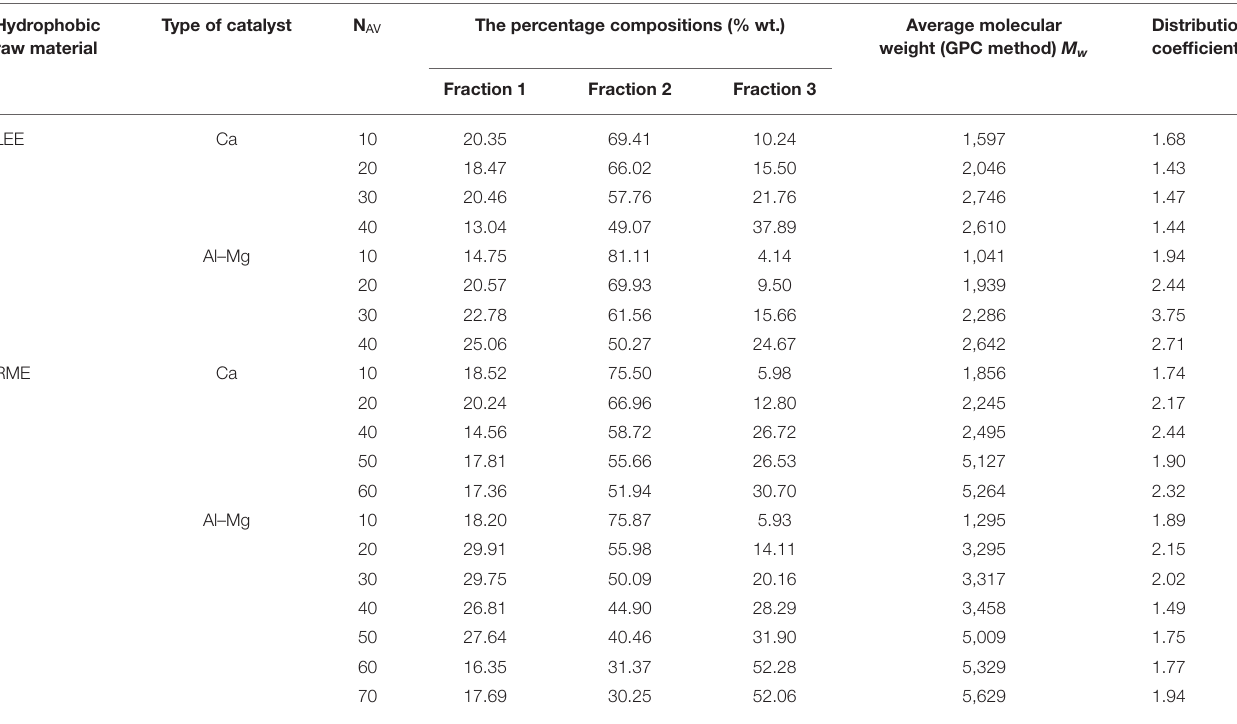
TABLE 3 | The results of the chromatographic analysis of the obtained ethyl and methyl esters oxyethylates (GPC/HPLC). Hydrophobic Type of catalyst N AV The percentage compositions (% raw material